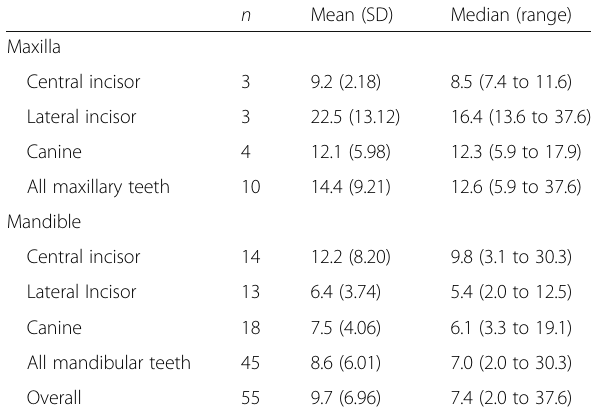
Table 2 Descriptive statistics of the angle (degrees) between the long axis of the actual and the estimated